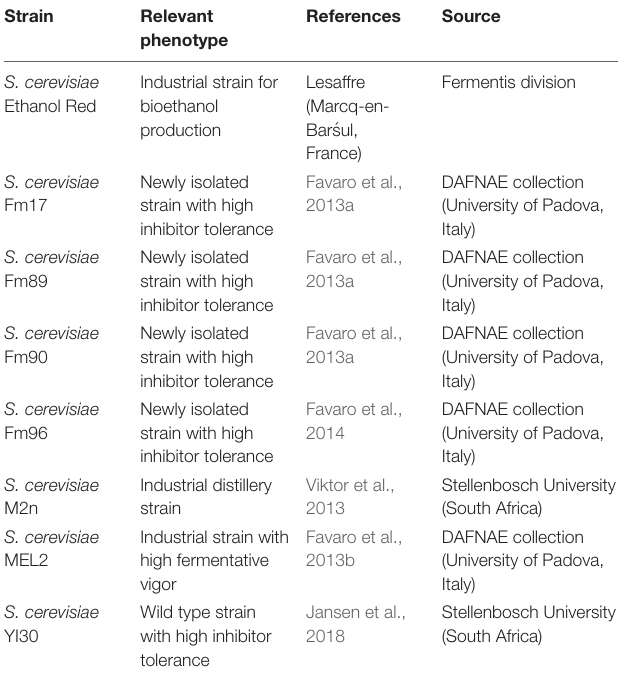
TABLE 2 | Yeast strains used in this study.